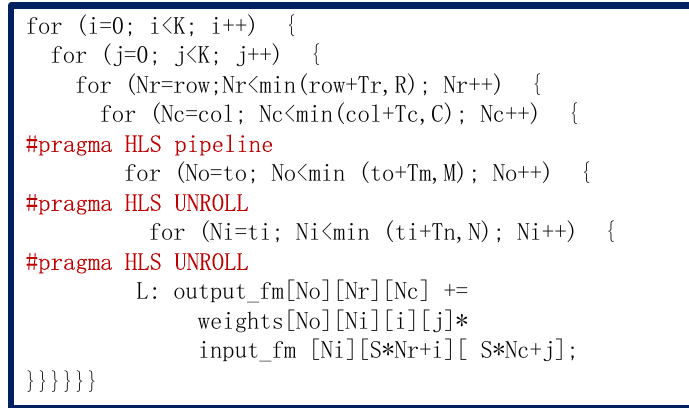
Figure 7. Sample code for optimizing loop operations.